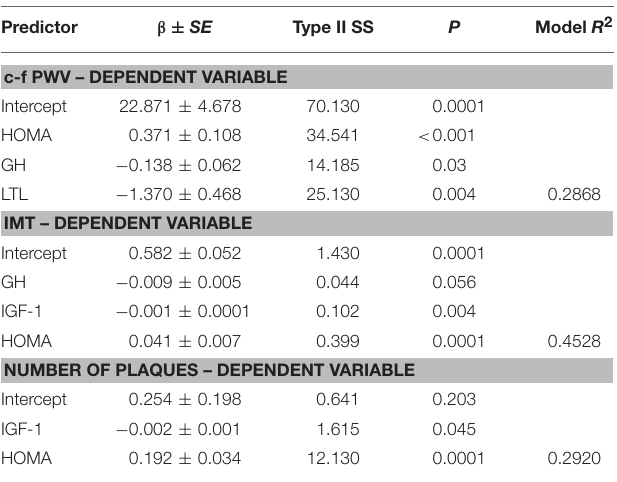
TABLE 6 | Stepwise multiple linear regression analysis (with adjustment for CVRF) of c-f PWV, IMT, Number of Plaques as dependent variables in the younger